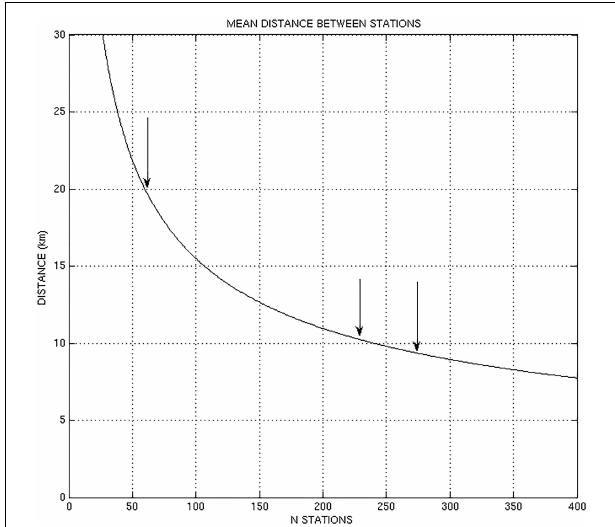
FIGURE 7 | Mean distance between stations. The arrows correspond to the three dataset.